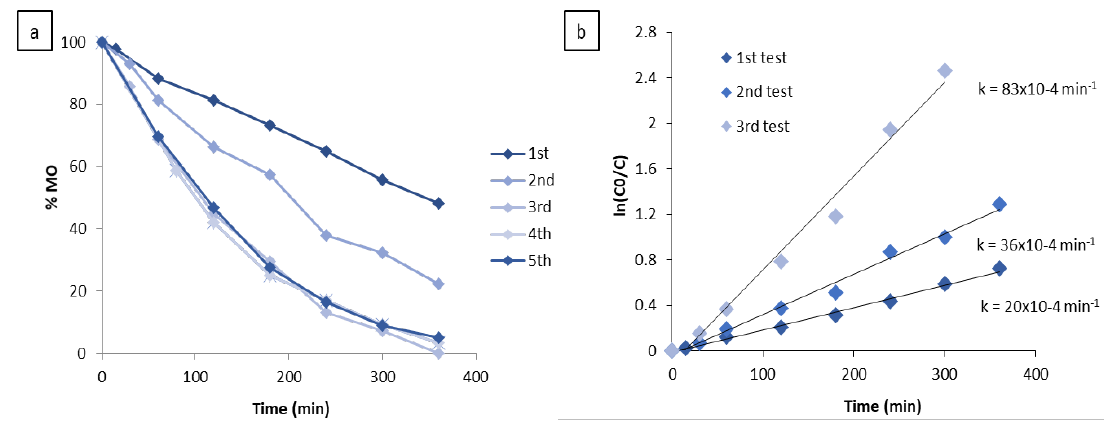
Figure 9. ( a ) Percentage of methyl orange (MO) degradation over time upon repetitive exposure to UV light of SiO 2 -TiO 2 -coated rhombic prism (diamond) post array, ( b ) Rate of reaction of MO degradation over time upon repetitive exposure to UV light of SiO 2 -TiO 2 -coated rhombic prism (diamond) post array.